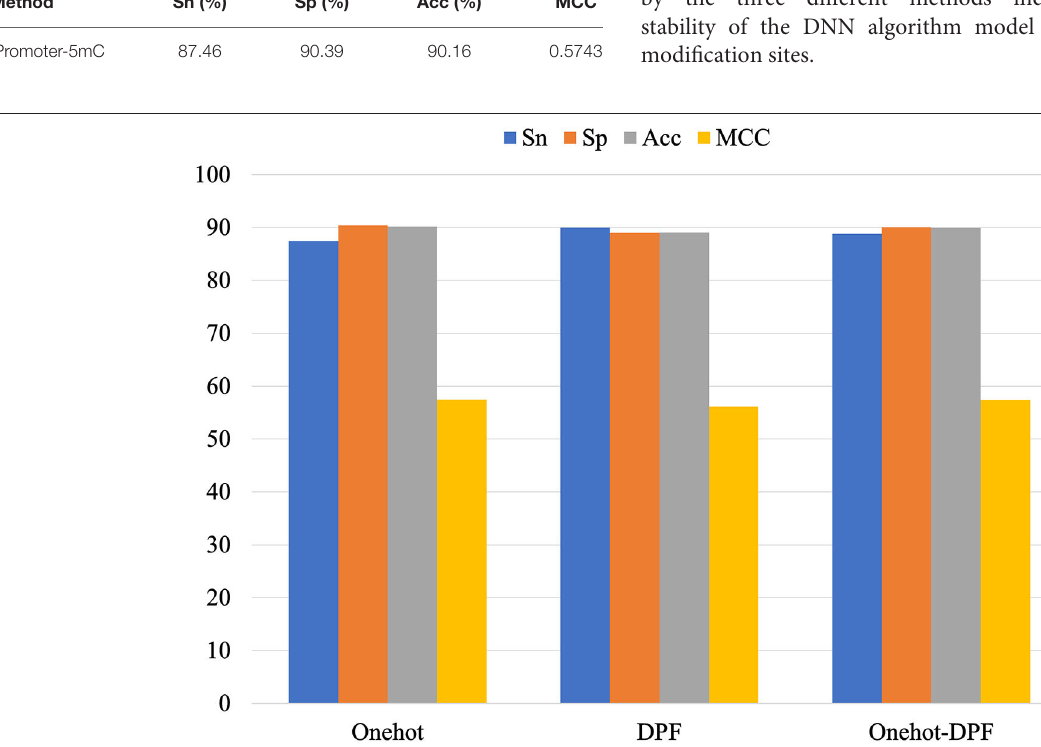
Frontiers in Cell and Developmental Biology |